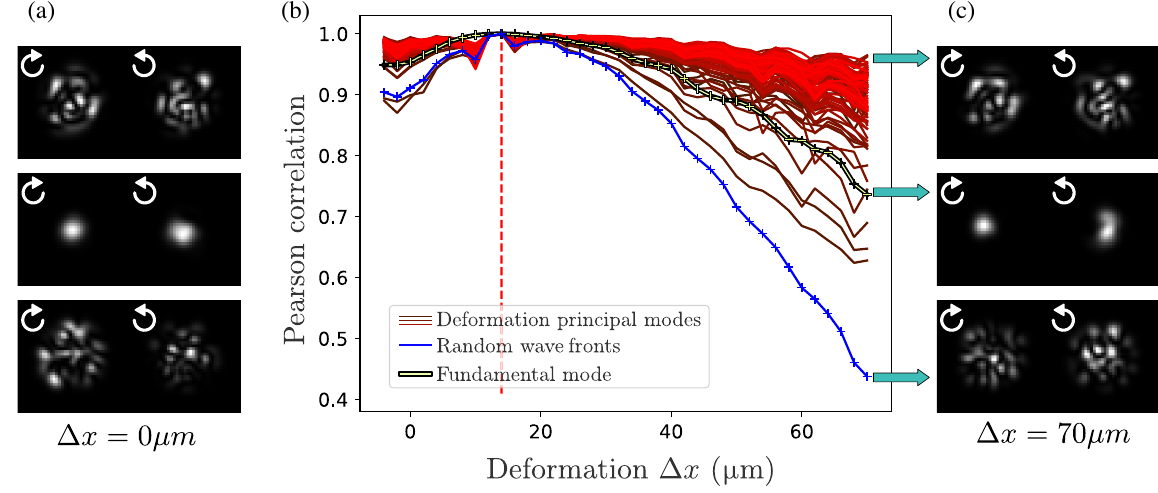
FIG. 3. Examination of the deformation principal modes. (a),(c) Output intensity profiles for the injection of a deformation principal mode, the fundamental mode of the fiber, and a random wave front for the minimal and maximal deformation. Each pair of patterns represents the intensity in the left and right circular polarization states of light. (b) Pearson correlation coefficient between the output intensity pattern at Δ x and the one at Δ x ¼ 14 μ m for all the deformation principal modes, the fundamental mode, and after averaging over 20 random input wave fronts.